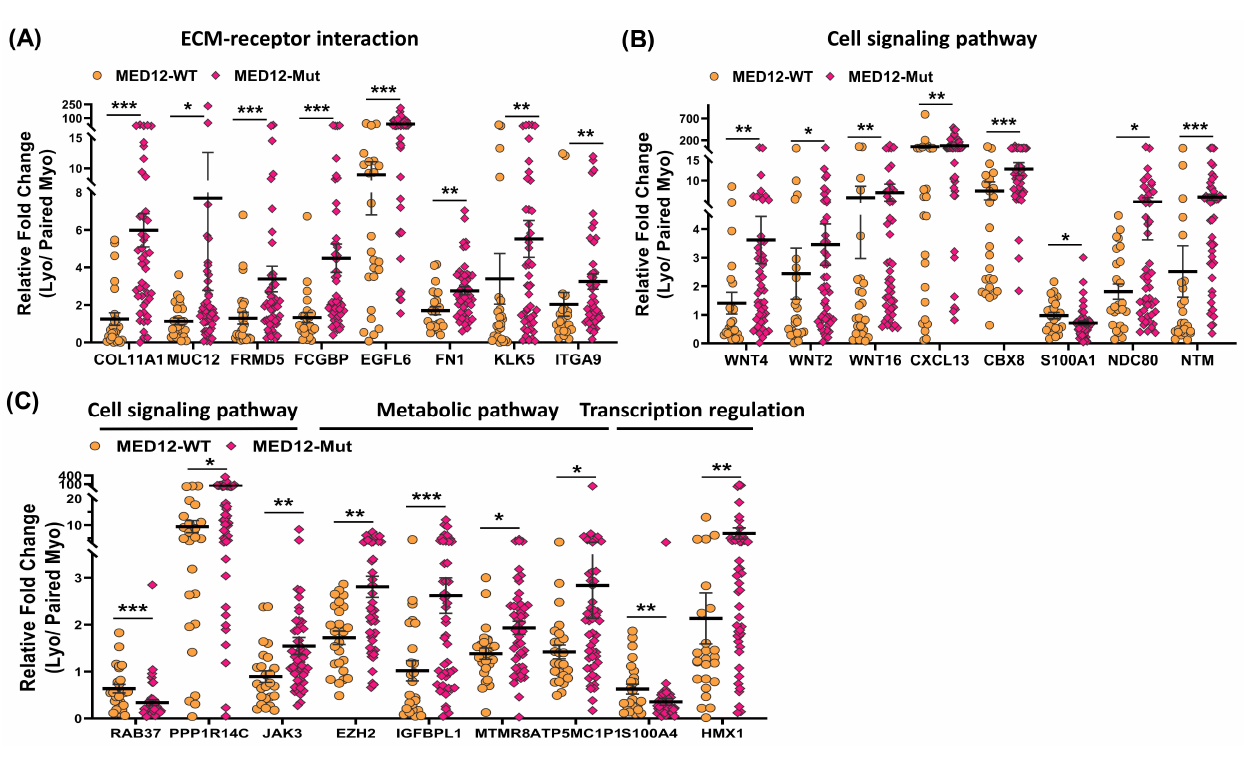
Figure 7. The expression of mRNA for ( A ) COL11A1, MUC12, FRMD5, FCGBP, EGFL6, FN1, KLK5, and ITGA9; ( B ) WNT4, WNT2, WNT16, CXCL13, CBX8, S100A1, NDC80, and NTM; ( C ) RAB37, PPP1R14C, JAK3, EZH2, IGFBPL1, MTMR8, ATP5MC1P1, S100A4, and HMX1 expressed as fold change (Lyo/paired Myo) in MED12-mutated (n = 48) and non-mutated (n = 25) specimens measured using qRT-PCR. The results are presented as mean ± SEM with p values (* p < 0.05; ** p < 0.01; *** p < 0.001) as indicated by the corresponding lines. Table 1. Genes selected based on the RNAseq analysis according to the MED12 mutation status.